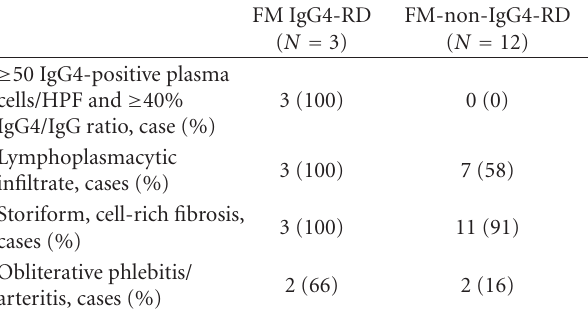
Table 2: Distribution of the diagnostic criteria of